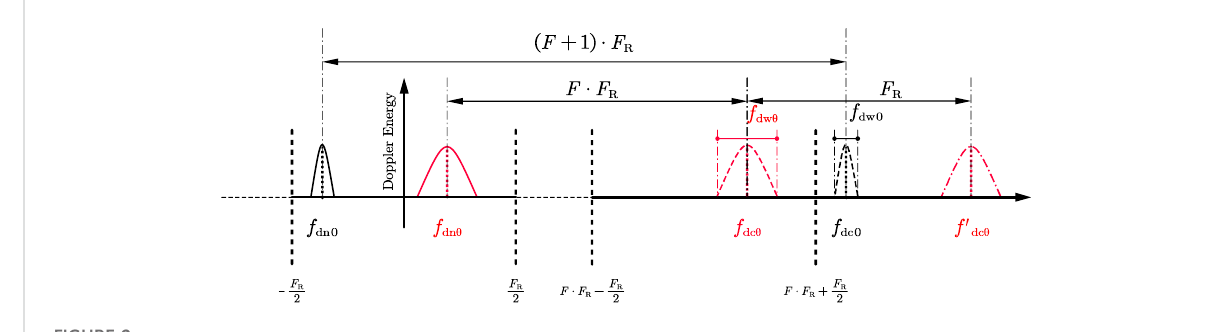
FIGURE 2 Schematic diagram of the residual velocity generated by solving Doppler